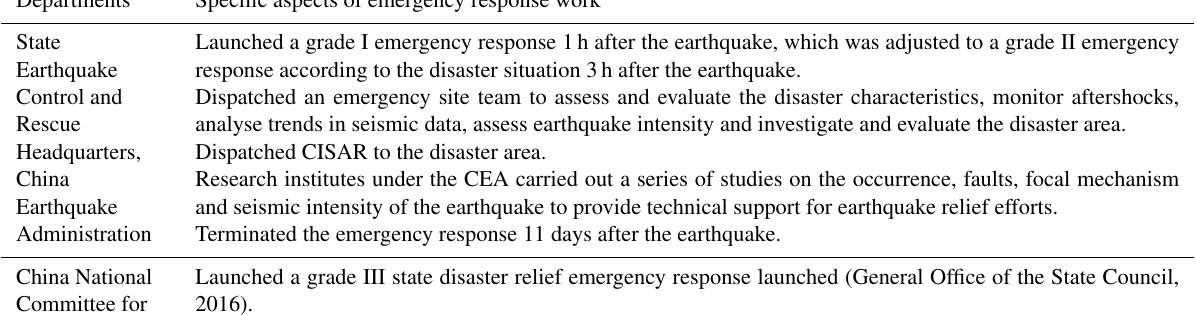
Table 1. Emergency responses of major governmental